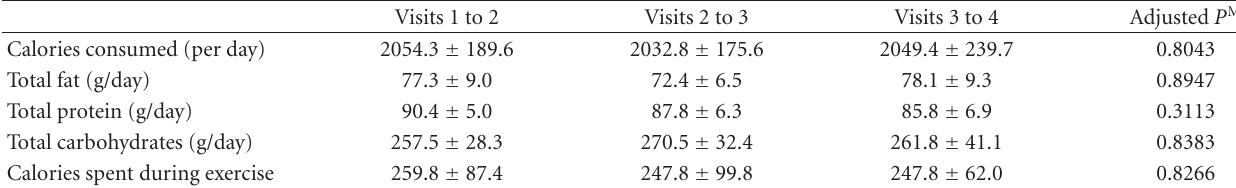
Table 3: Dietary and exercise consistency throughout the study. Visits 1 to 2 Visits 2 to 3 Visits 3 to 4 Adjusted P